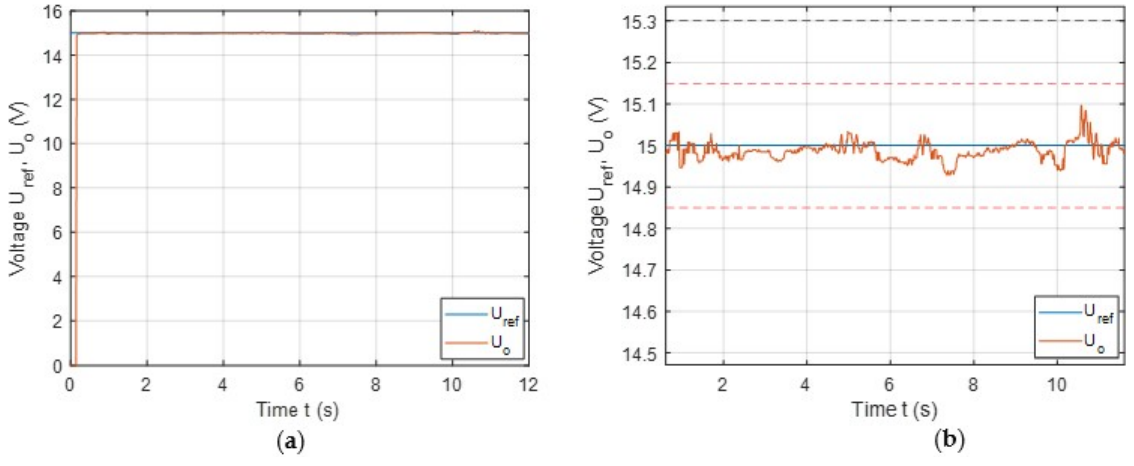
Figure 11. Influence of load change on the output voltage: ( a ) large scale; ( b ) small